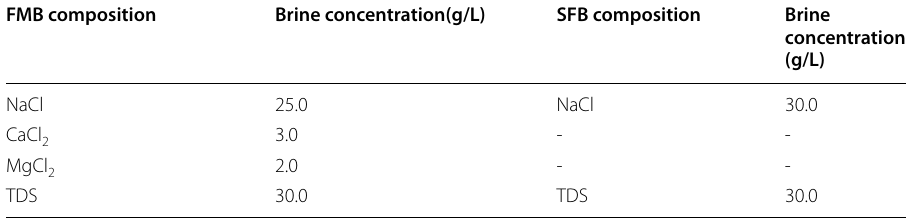
Table 2 Composition of synthetic